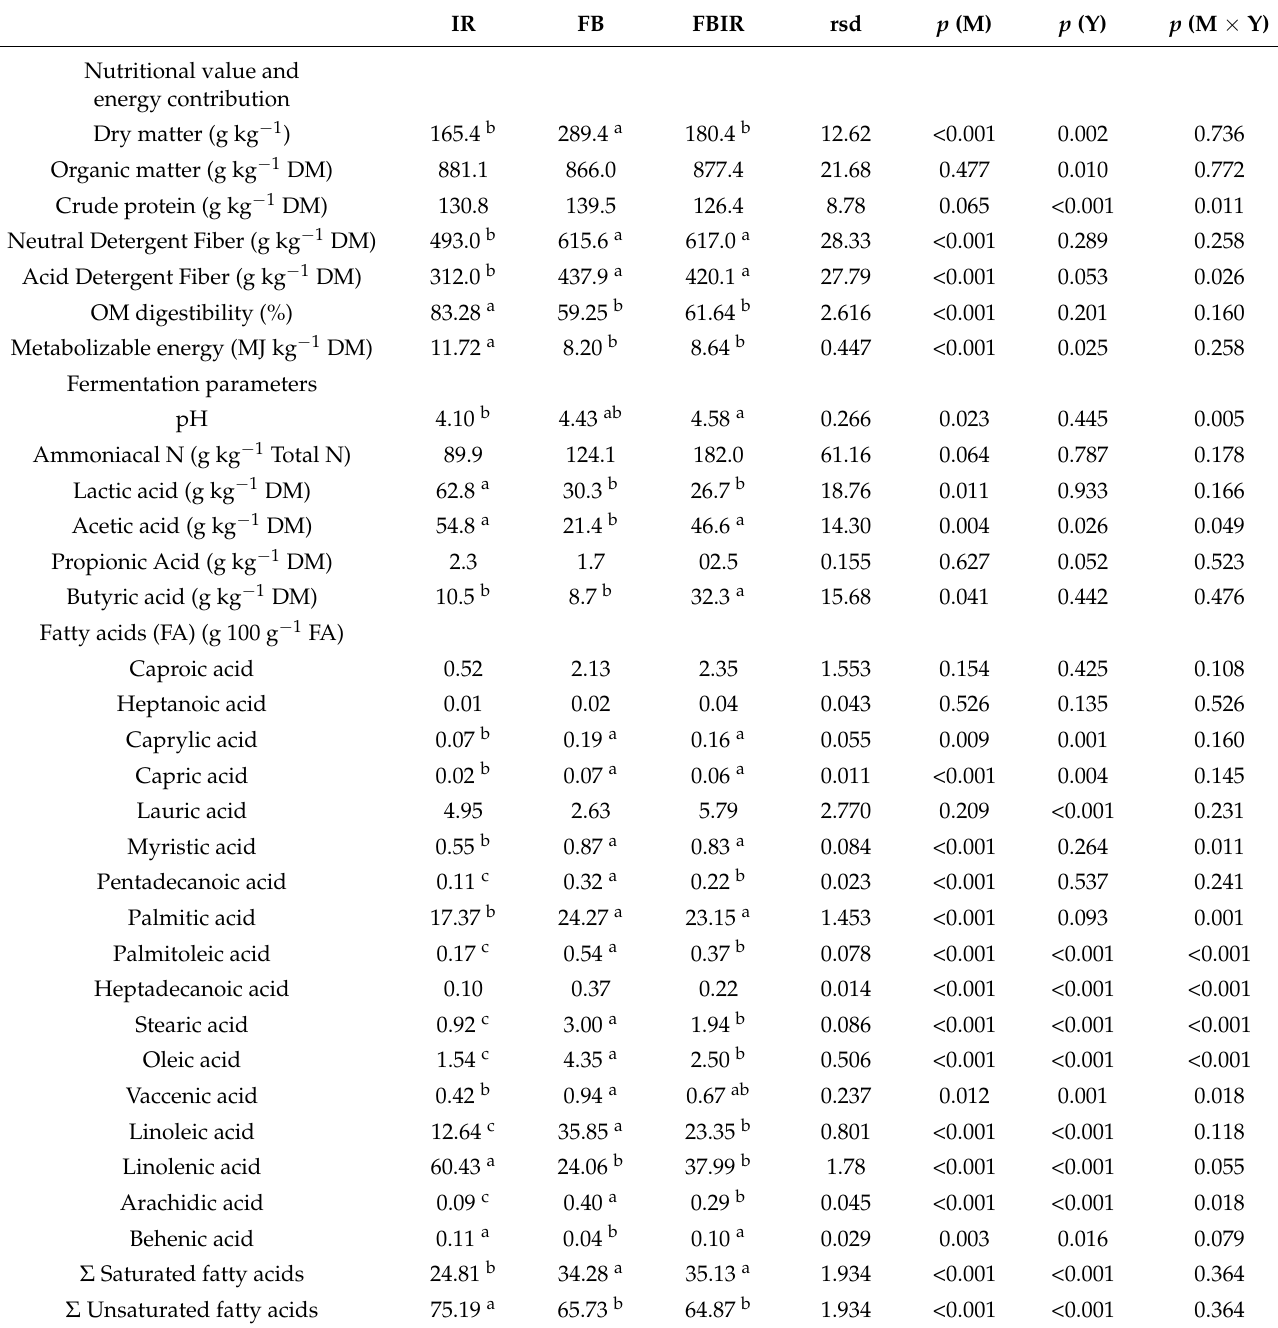
Table 2. Nutritional value, metabolizable energy, fermentative parameters, and fatty acid profile of silages used to formulate the total mixed rations. IR FB FBIR